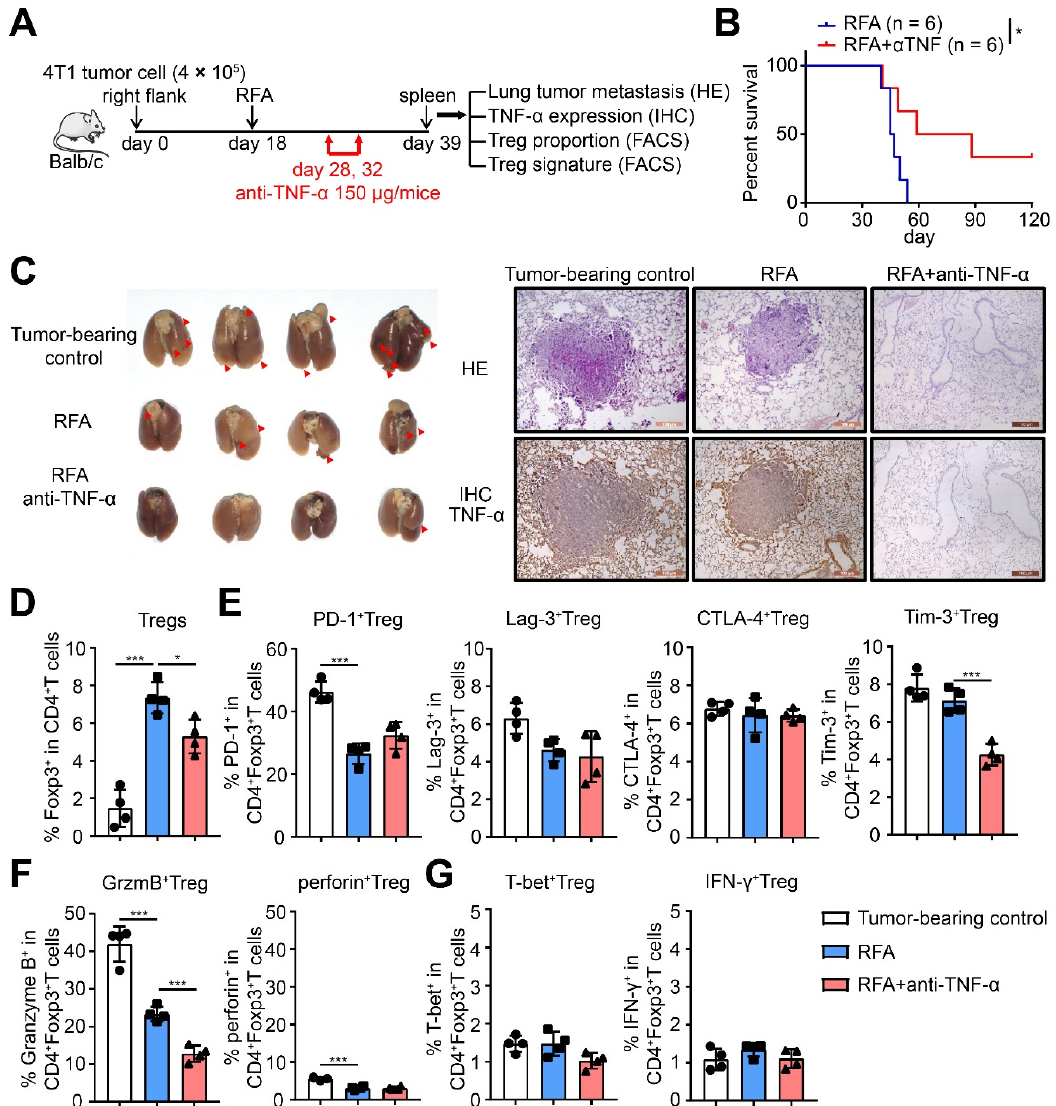
Figure 7. TNF- α neutralization after RFA treatment inhibited Treg function and suppressed tumor metastasis, as well as promoted the long-term survival of mice. ( A ) Schematic of experimental design. For TNF- α neutralization in vivo, 150 µ g antibody was injected intraperitoneally in 100 µ L PBS on day 10 and 14 after RFA treatment. ( B ) Kaplan–Meier survival curve of single RFA therapy or combination with TNF- α neutralization. n = 6 for each group. ( C ) Photographic images of lungs (left), HE staining (upper-right) and IHC staining of TNF- α (brown, lower right) from tumor-bearing control (39 days after inoculation), RFA or cryo-thermal treated (21 days after treatment) mice. ( D – G ) The proportion of Tregs ( D ), the expression of inhibitory checkpoints ( E ), the expression of suppressive cytokines ( F ) and the expression of T-bet and IFN- γ ( G ) of Tregs were detected on day 21 after single RFA, or combined with TNF- α neutralization by flow cytometry. n = 4 for each group. * p < 0.05, *** p <